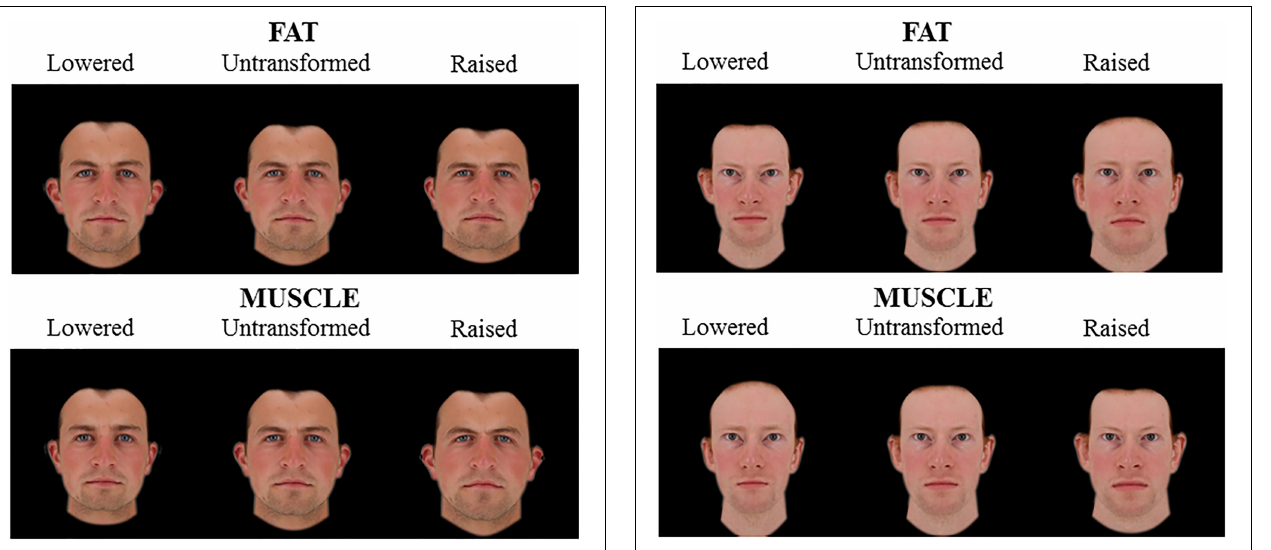
FIGURE 2 | 2D Male face shape associated with fat mass (top) and muscle mass (bottom). Individual faces (middle) were transformed to reflect face shapes associated with less fat/muscle mass (–4 BMI units, left) or more fat/muscle mass (+4 BMI units, right) based on the difference in the face shape between low and high fat/muscle prototypes for the 2D version of 3D face set. The participant gave written informed consent for the publication of his image and use in the experiments.